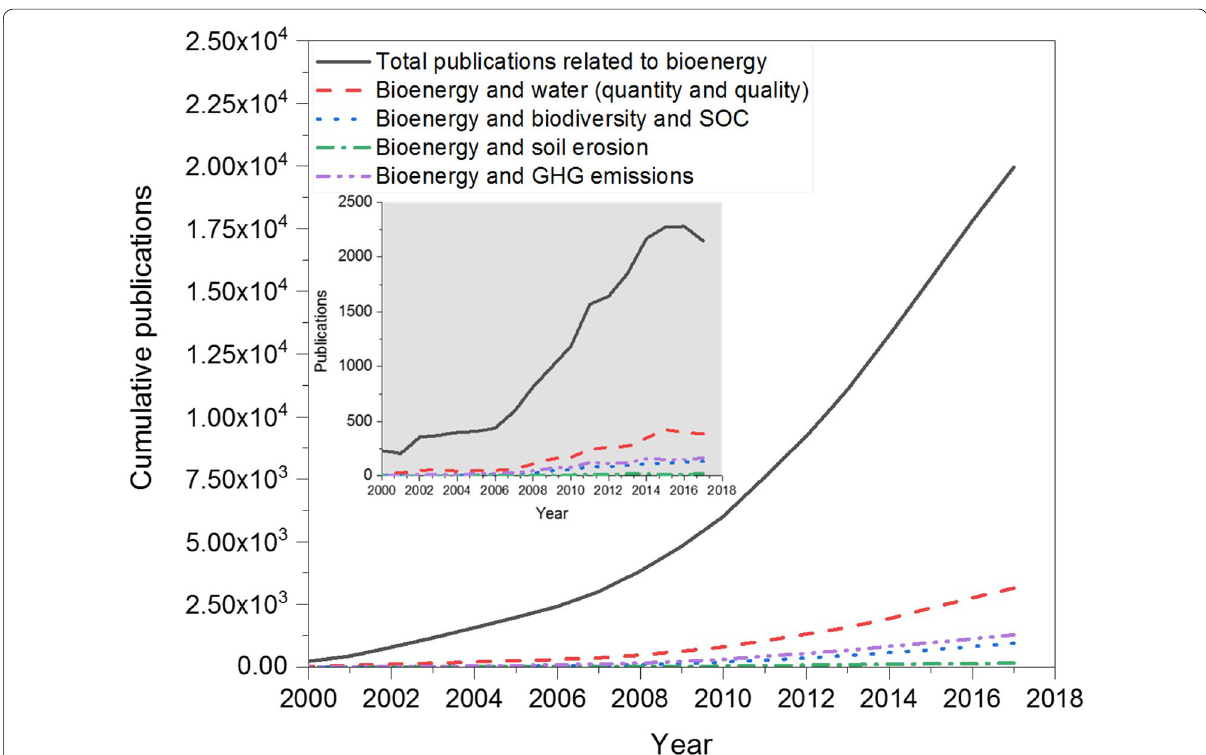
Fig. 1 Publications related to bioenergy production and its environmental effects (water quantity and quality, biodiversity and SOC, soil erosion, and GHG emissions) since the year of 2000. The inserted figure indicates the annual change of publications within the reference period